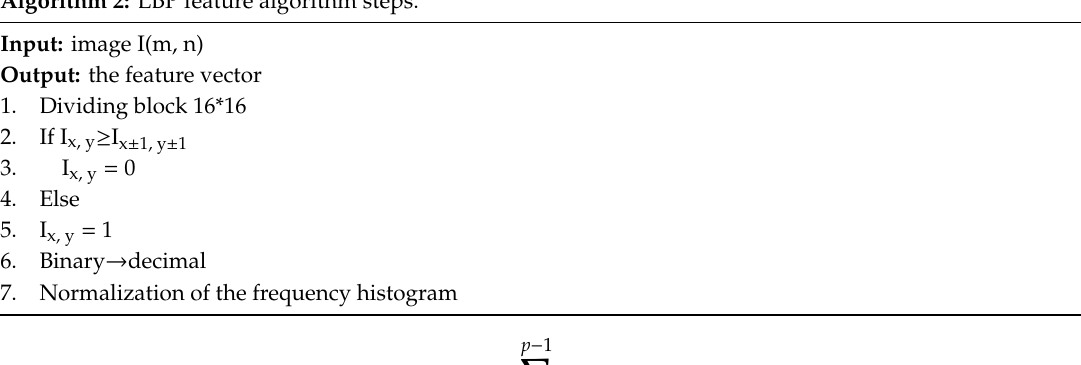
Algorithm 2: LBP feature algorithm